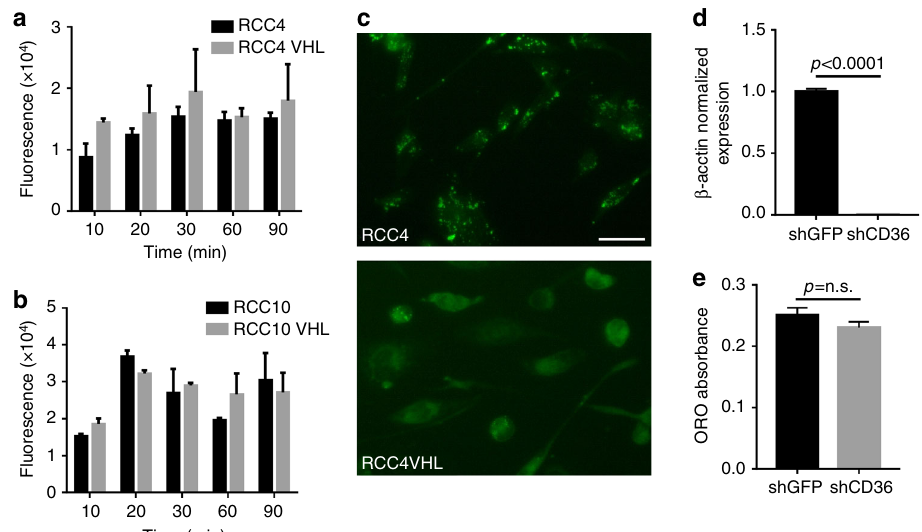
Fig. 3 Lipid deposition in VHL-de fi cient cells is not due to altered fatty acid import. a Quanti fi cation of fl uorescence in RCC4 and RCC4 VHL cells at indicated times after exposure to BODIPY-dodecanoic acid. b Quanti fi cation of fl uorescence in RCC10 and RCC10 VHL cells at indicated times after exposure to BODIPY-dodecanoic acid. c Representative fl uorescent images of BODIPY-labeled RCC4 and RCC4 VHL cells at 24 h after exposure to BODIPY-dodecanoic acid. Bar = 10 μ m. d Quantitative real-time PCR detection of CD36 expression after shRNA knockdown. e Quanti fi cation of Oil Red O staining of RCC4 cells with shGFP or shCD36 knockdown. Error bars represent standard deviations. p values of two-tailed Student ’ s t tests are